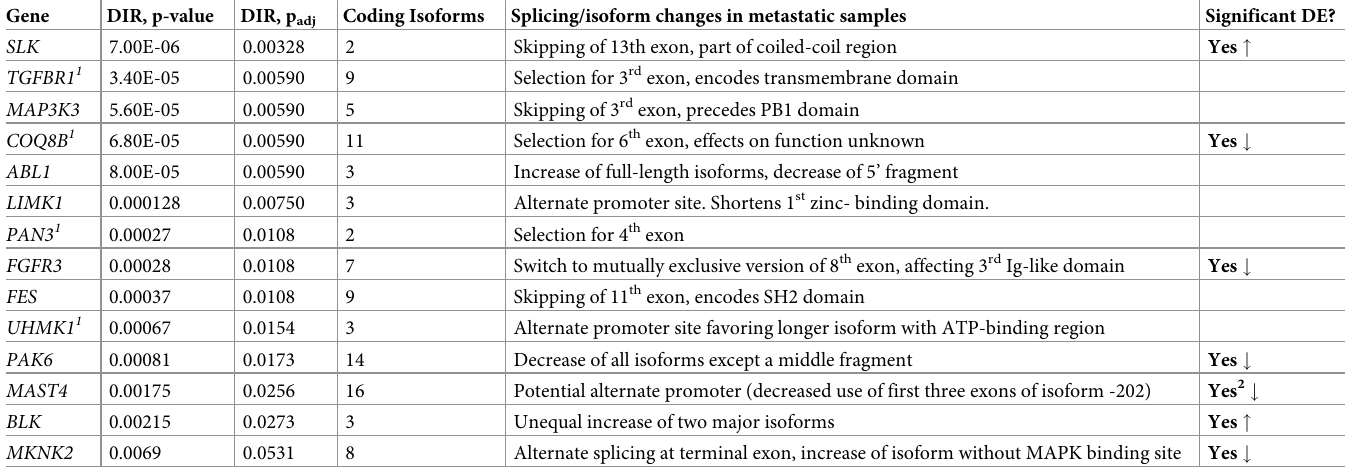
Table 4. Example genes with significant changes in isoform ratios after 3’ bias and sample impurity filtering.